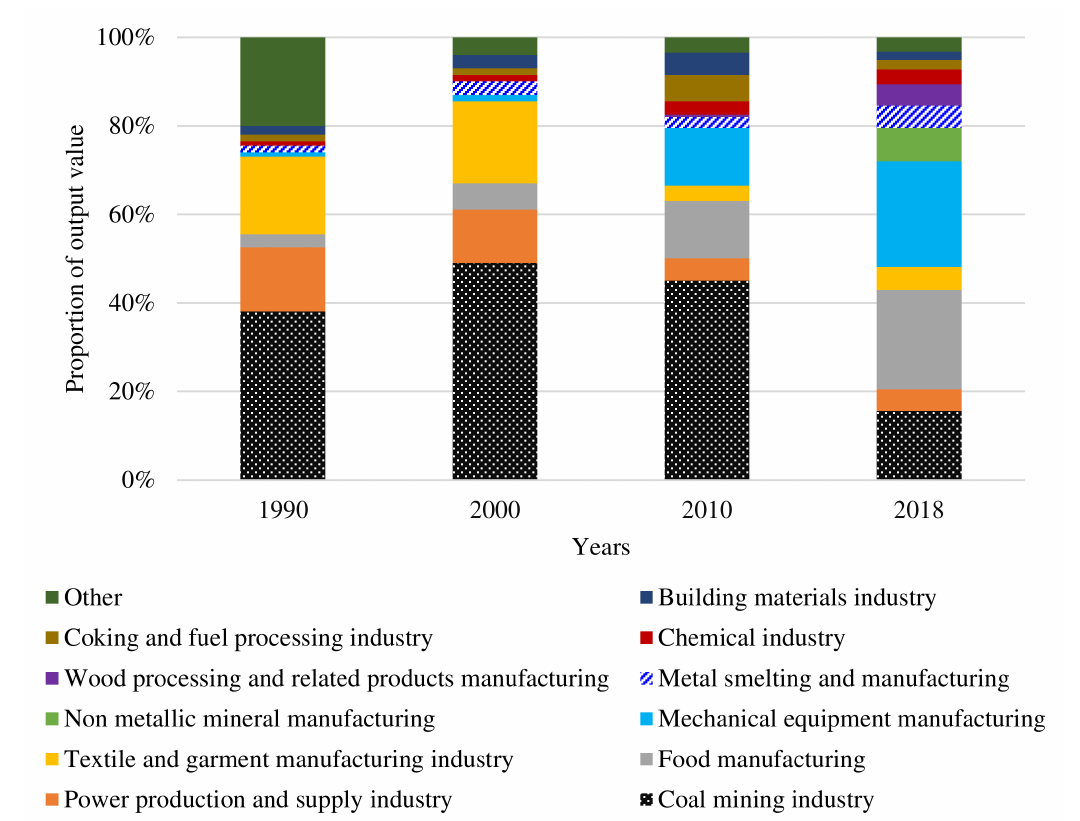
Figure 3. Structure of output value of major industrial sectors in Huaibei